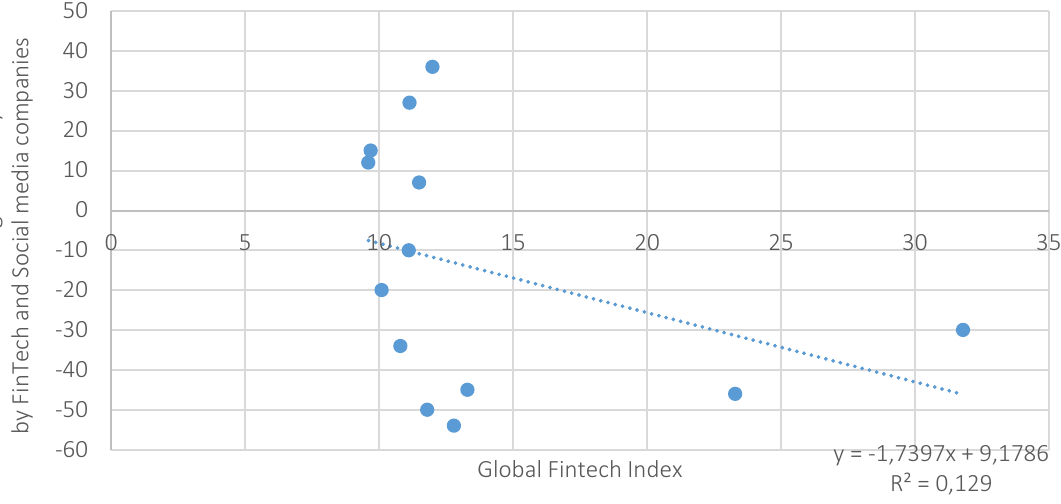
Figure С4. Confidence in privately issued digital money and FinTech